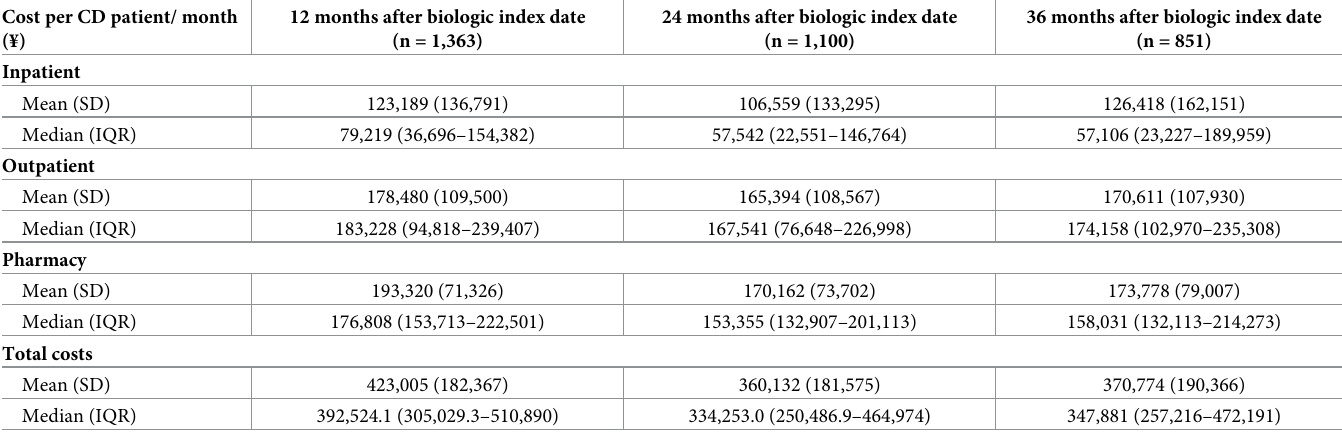
Table 5. Direct costs 12, 24, and 36 months after biologic